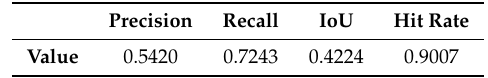
Table 4. Quantitative evaluation for the defect detection module.